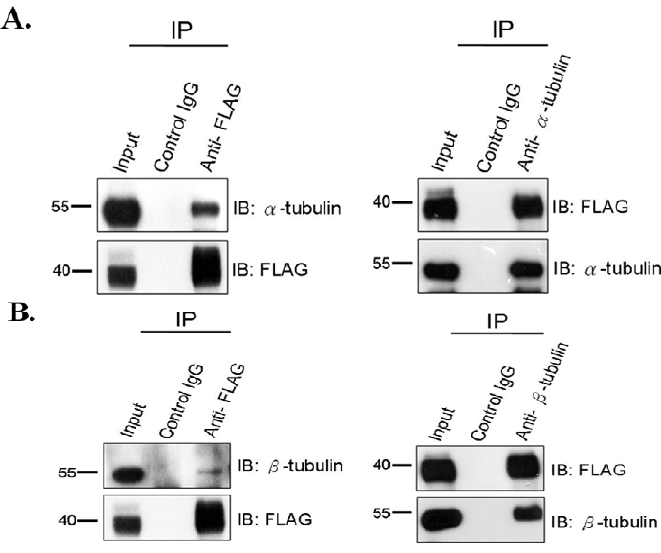
of FLAG-SEPT12 and α -tubulin. Lysates from transfected NTERA-2 d.D1 cells were immunoprecipitated (IP) with anti-FLAG antibody ( left panel, lane3), anti- α -tubulin ( right panel, lane 3), or a nonspecific control IgG ( left and right panel, lane 2), followed by immuno-blotting (IB) with anti- α -tubulin or anti-FLAG antibody. Input protein (5%) was used as control of immuno-blotting (IB) in the transfected cell lysates; ( B ) Co-IP of FLAG-SEPT12 and β -tubulin. The data presents as ( A